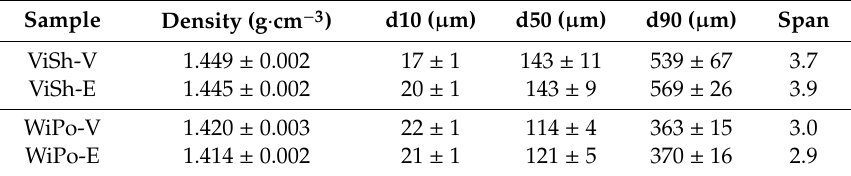
Figure 2. Particle size distribution for ViSh-V (- -), ViSh-E ( ∙ ∙ ), WiPo-V (- -) and WiPo-E ( ∙ ∙ ) in volume. Table 2. Filler density and apparent diameter (in volume). Sample